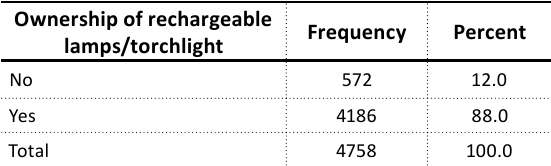
Table 11. Ownership of rechargeable lamps/ torchlight